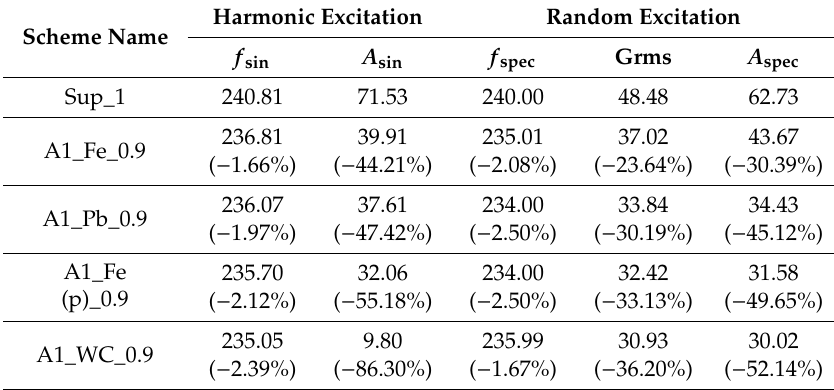
Table 9. Effect of particle/powder material. Table 9. E ff ect of particle / powder